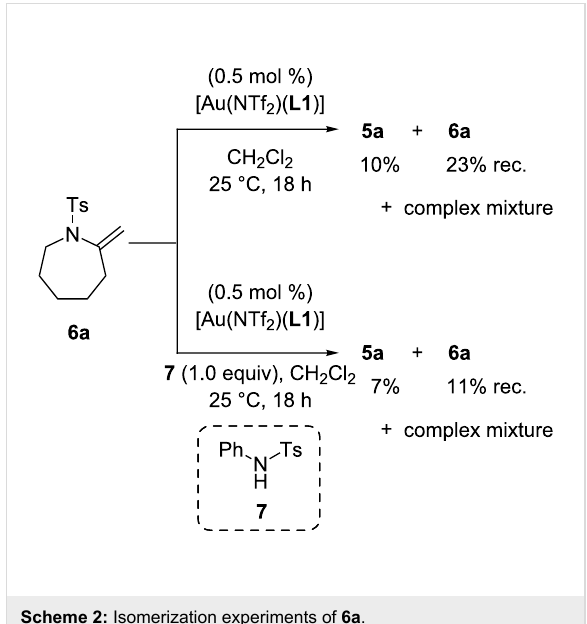
Scheme 2: Isomerization experiments of 6a